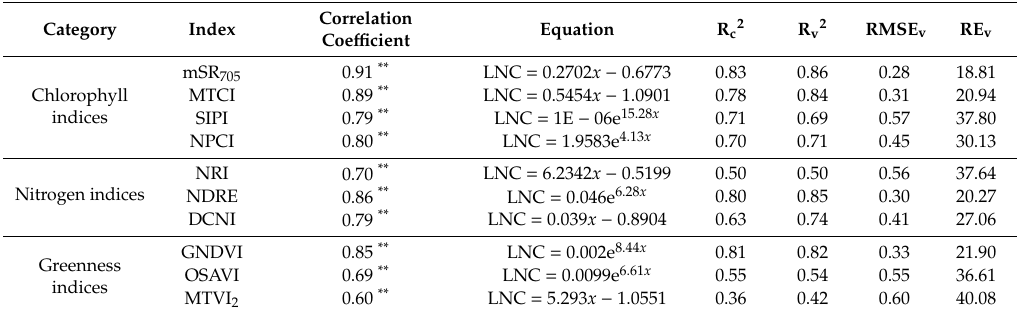
indices. ** at 0.01 significance level.